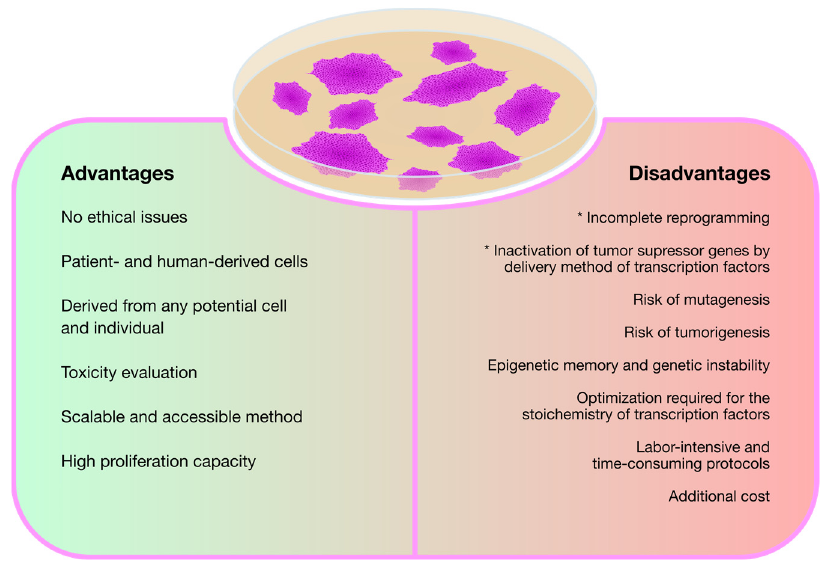
Figure 3. Di ff erent sources of mesenchymal stem cells (MSCs).